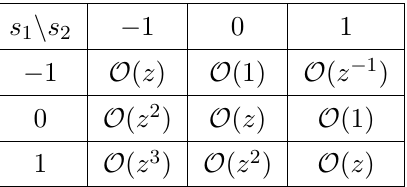
Table 3 . The large- z behavior of amplitudes with particles 1 and 2 in different spin states. s 1 and s 2 are spin projections of particles 1 and 2 in the z